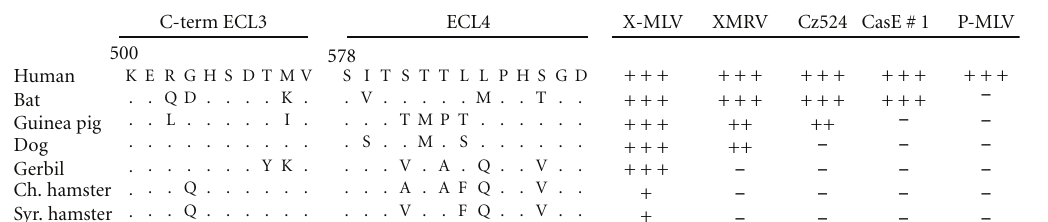
Figure 9: Susceptibility of various mammalian cells to XP-MLVs. Infectivity is measured as the log 10 titer of FFU/100 μ L of viral Env pseudotypes carrying the LacZ reporter. Log 10 titer: +++, > 3; ++, 2-3; +, 1-2. Infectivity of Chinese hamster cells can be increased by treatment with glycosylation inhibitors. Amino acid sequences are shown for the receptor determining regions of ECL3 and ECL4.